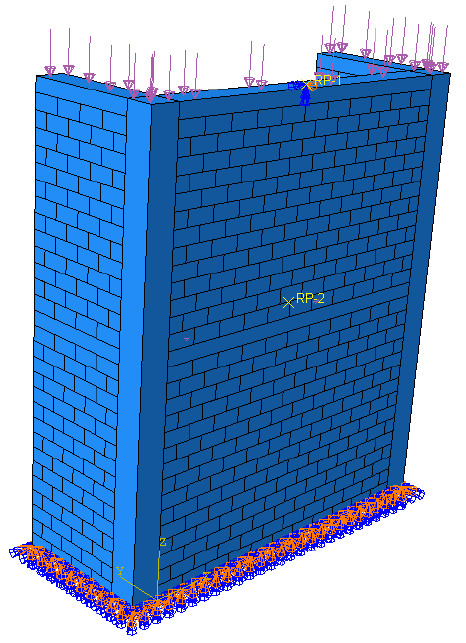
Figure 7. One-half model of MSBD.